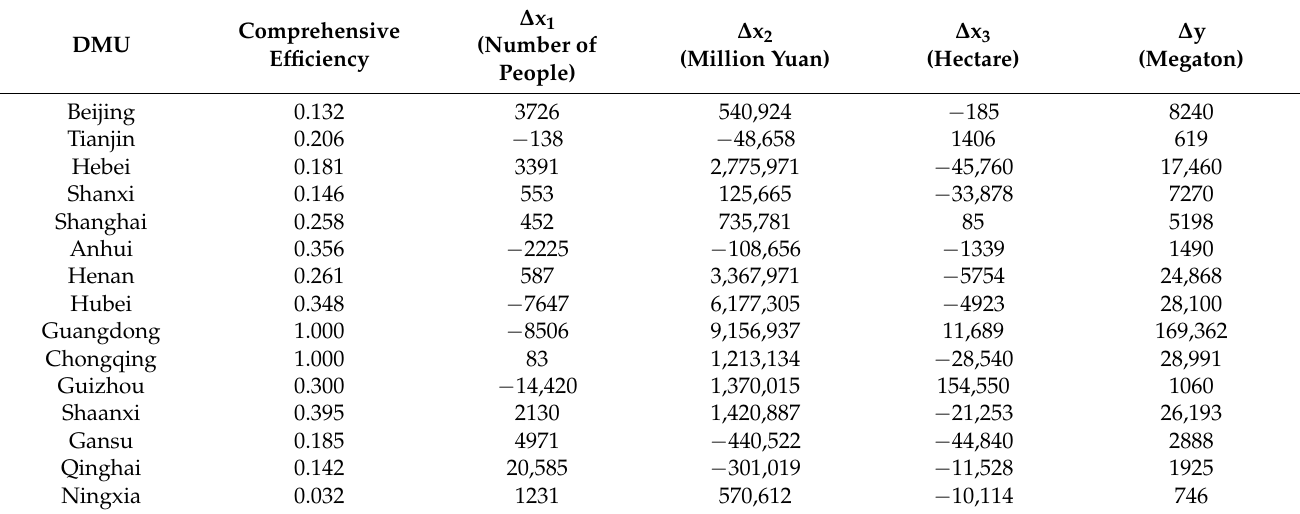
Table 5. Inverse DEA results for efficiency reduction